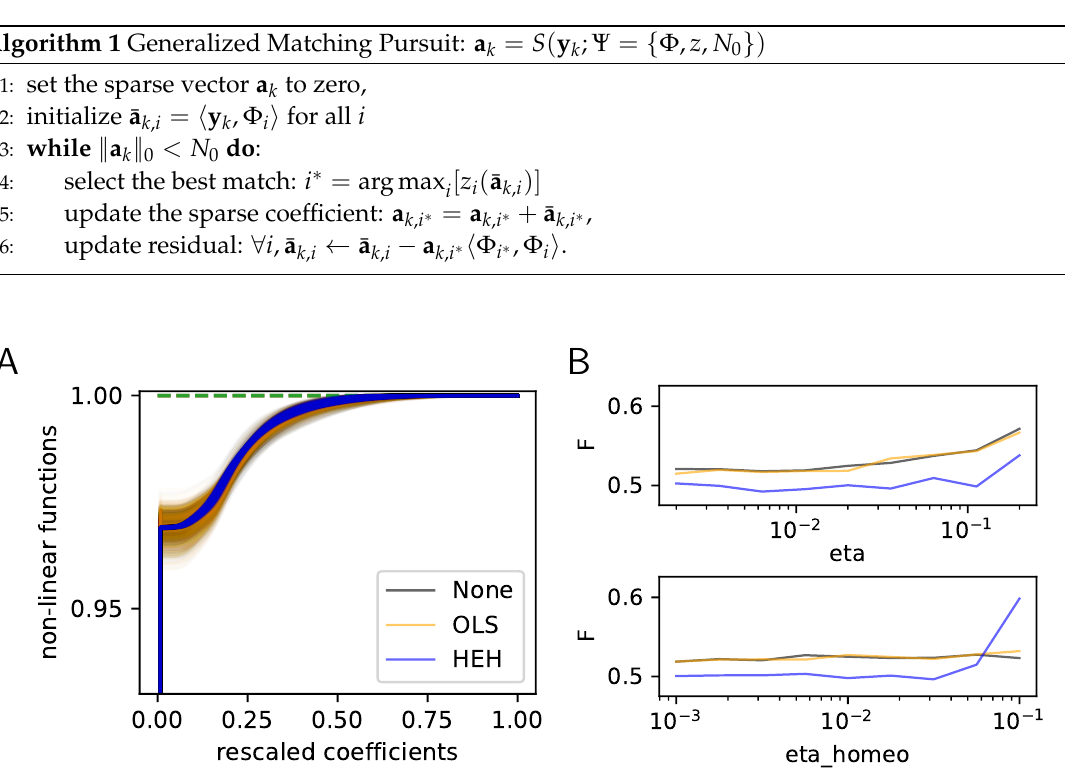
Figure 2. Histogram Equalization Homeostasis and its role in unsupervised learning. ( A ) Nonlinear homeostatic functions z i , ∀ i learned using Hebbian learning. These functions were computed for different homeostatic strategies ( None , OLS or HEH ) but only used in HEH . Note that for our choice of N 0 = 21 and N = 26 2 = 676, all cumulative functions start around 1 − N 0 / N ≈ 0.968. At convergence of HEH , the probability of choosing any filter is equiprobable, while the distribution of coefficients is more variable for None and OLS . As a consequence, the distortion between the distributions of sparse coefficients is minimal for HEH , a property which is essential for the optimal representation of signals in distributed networks such as the brain. ( B ) Effect of learning rate η ( eta ) and homeostatic learning rate η h ( eta_homeo ) on the final cost as computed for the same learning algorithms but with different homeostatic strategies ( None , OLS or HEH ). Parameters were explored around a default value and over a 4 octaves logarithmic scale. This shows that HEH is robust across a wide range of